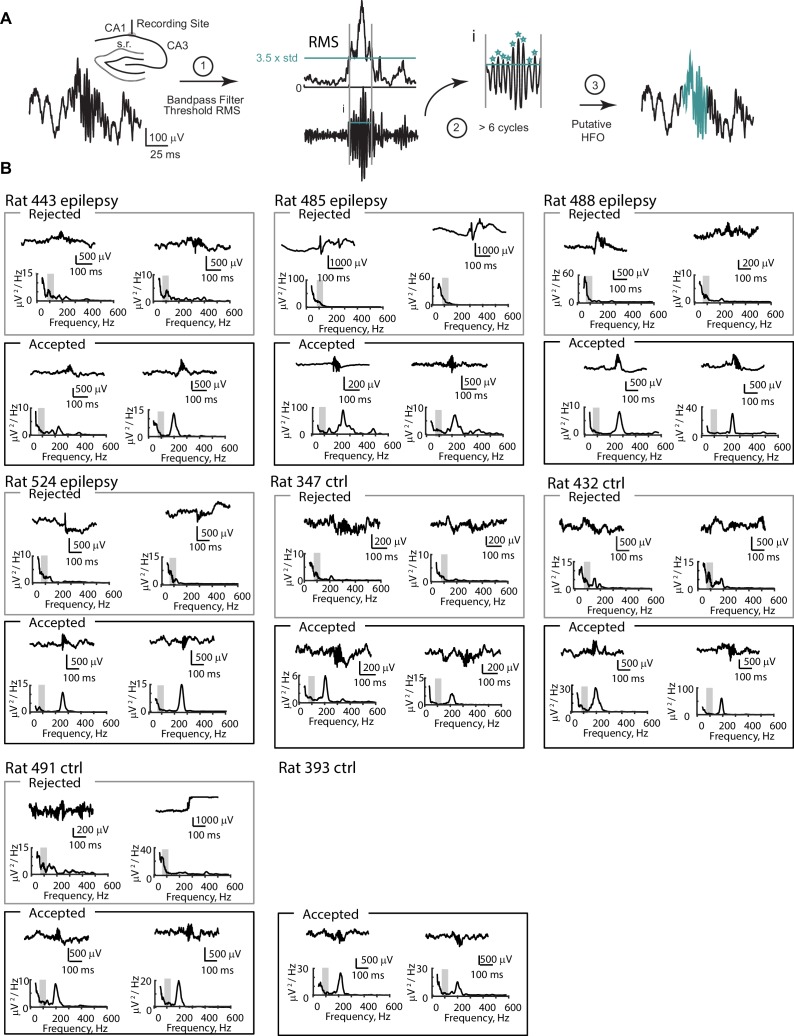
Detection criteria for high-frequency oscillations (HFO).(A) LFP recordings from the CA1 cell layer were bandpass filtered and putative HFO events were detected when the RMS surpassed 3.5 standard deviations (step 1) and when the event had at least five cycles (step 2). (B) As a third step to confirm that HFOs were not misidentified as fast gamma rhythm or a noise artifact, putative HFOs were either accepted or rejected based on peak frequency of the power spectrum. Events were only accepted if the peak power at frequencies greater than 150 Hz was higher than the peak power from 75 to 125 Hz (shaded grey region). For each animal included in the study, two rejected and two accepted events are depicted, except for rat 393, in which all putative events were accepted.